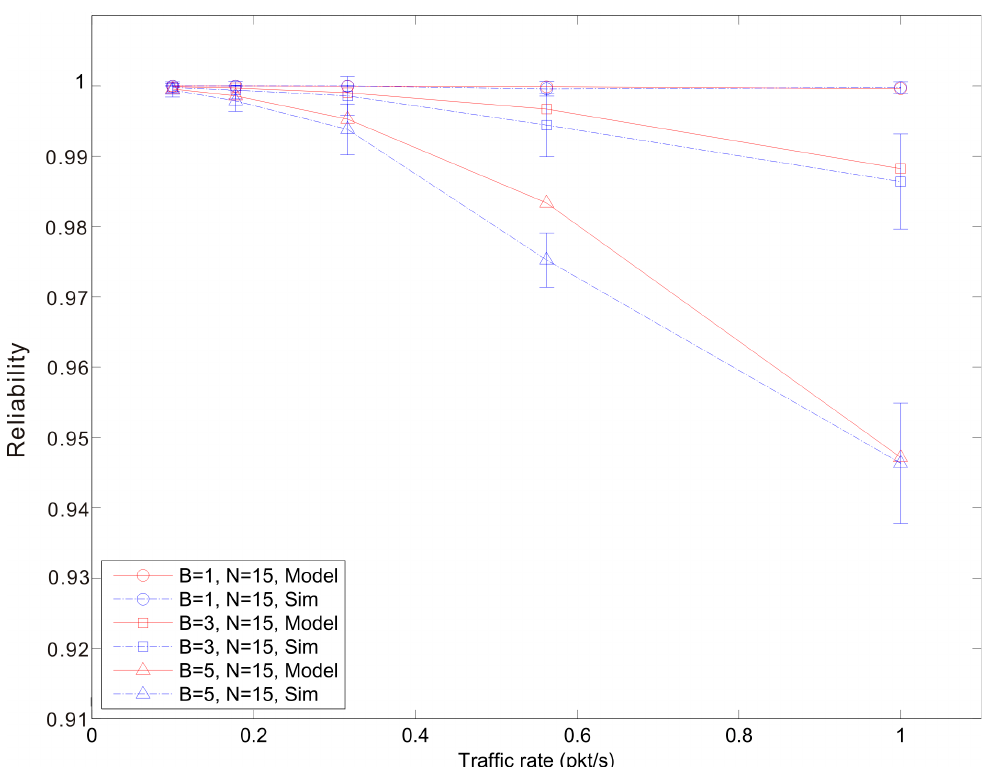
Figure 8. Blockwise reliability versus traffic rate for a star topology network composed by 15 nodes.